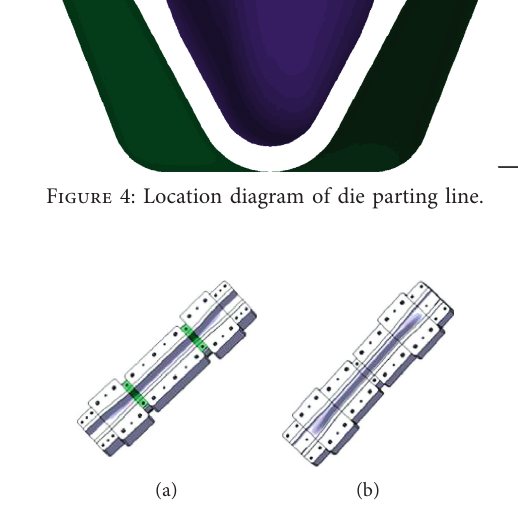
Figure 5: Structure drawing of punch and matrix insert: (a) structure of an inlaying matrix; (b) structure of an inlaying punch.